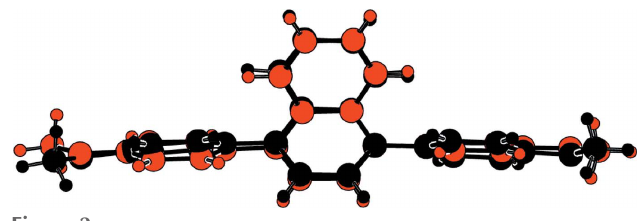
Figure 2 An overlay diagram of the first (red image) and inverted-second (black) independent molecules of the title